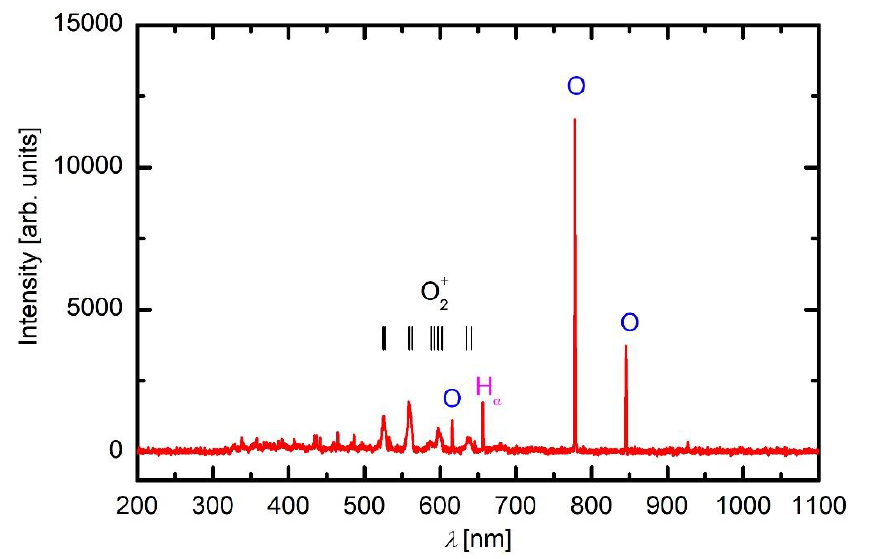
Materials 2020 , 13 , x FOR PEER REVIEW Figure 3. A spectrum of plasma in oxygen at 10 Pa and 200 W. Figure 3. A spectrum of plasma in oxygen at 10 Pa and 200 W.